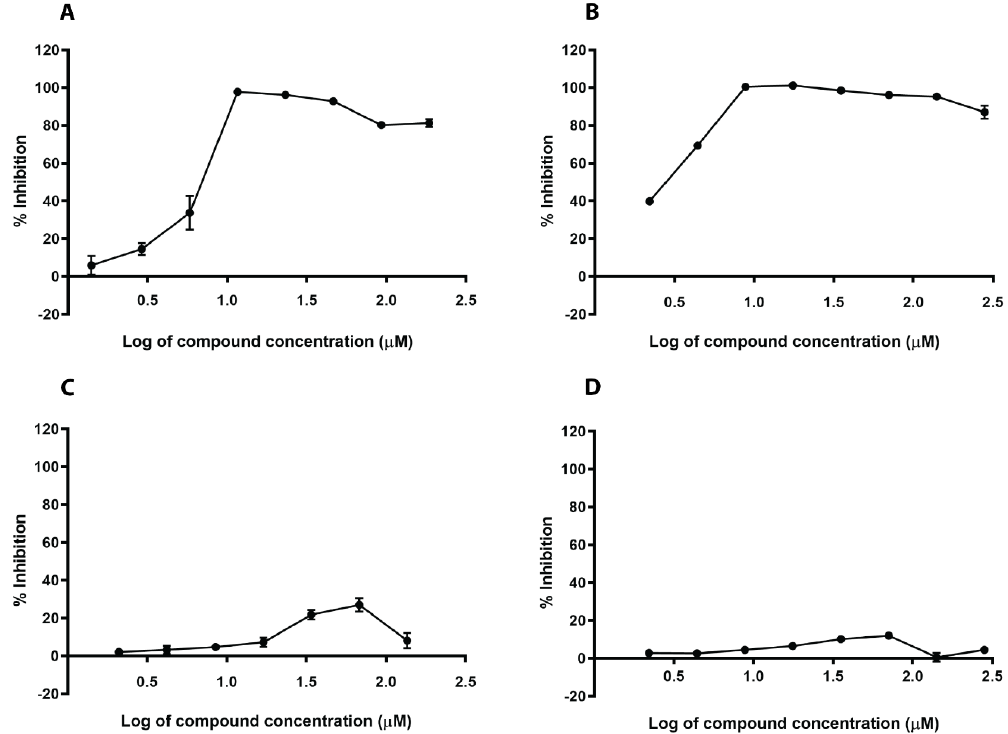
Figure 4. Effect of hit compounds and known inhibitors on the growth of S. aureus Newman strain. N1287 ( A ), N2576 ( B ), curcumin ( C ), and chlorogenic acid ( D ). The results are mean values and SE of three replicates.